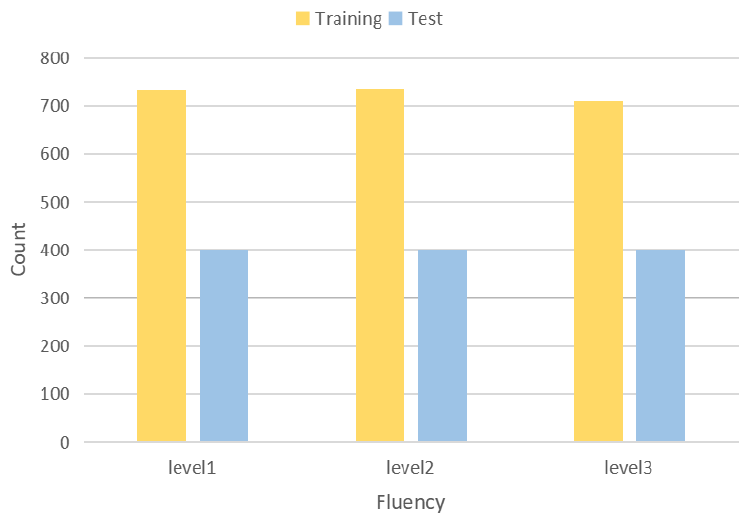
Figure 5. The distribution of fluency scores on the training and test sets of PSCPSF.